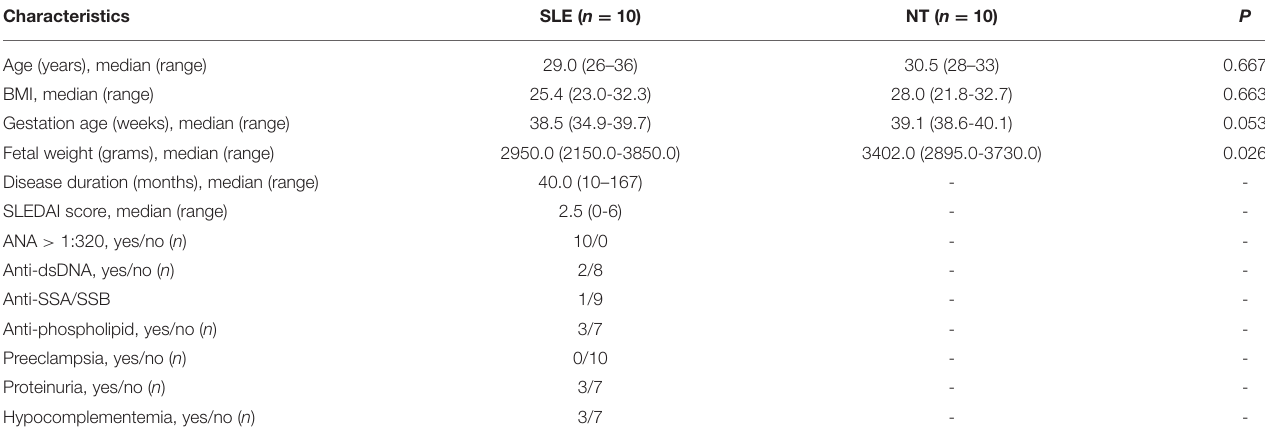
TABLE 1 | Clinical